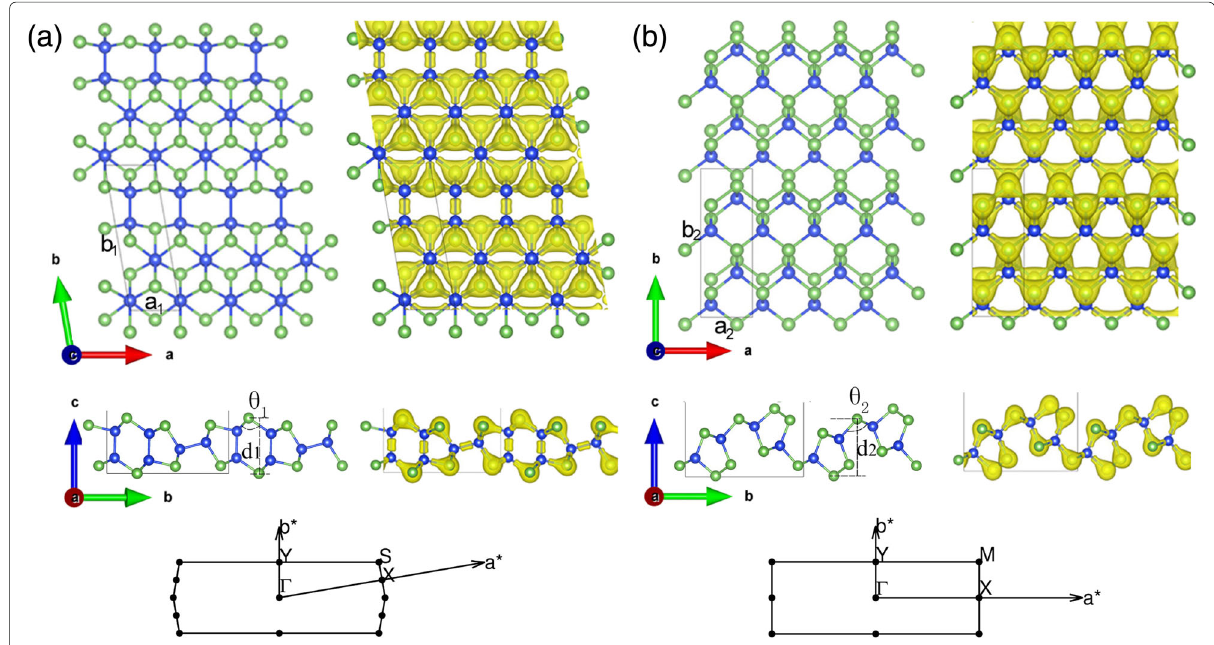
Fig. 1 Geometrical structure and electron density distribution of monolayers SiAs and SiAs 2 . (Color online) Top and side views of monolayers a SiAs and b SiAs 2 geometrical structure and electron density distribution and the associated Brillouin zone. The blue and green ball indicate the Si and As atom,